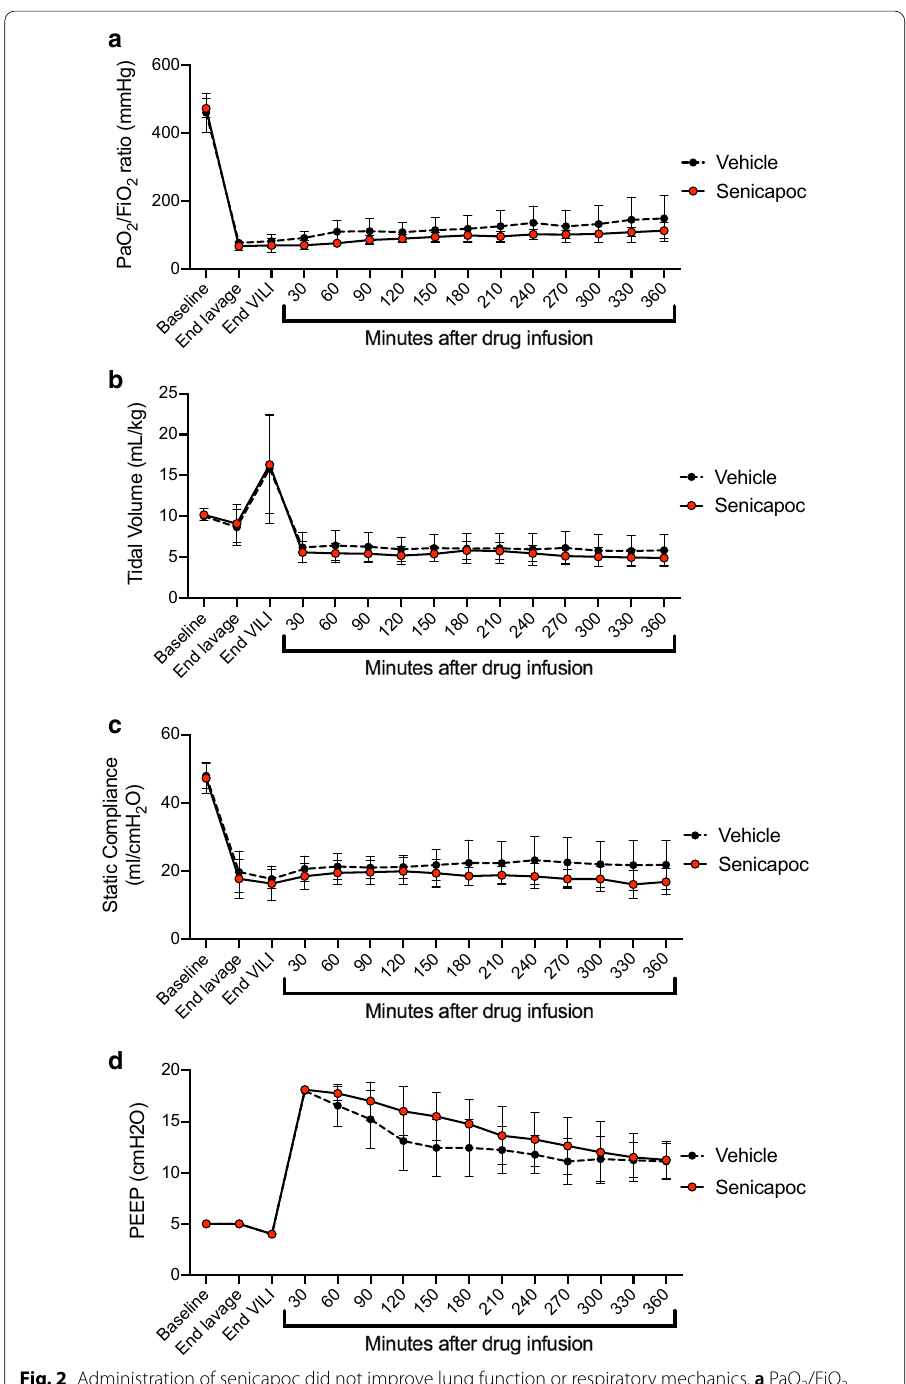
SD. Vehicle, n 9 and ± =